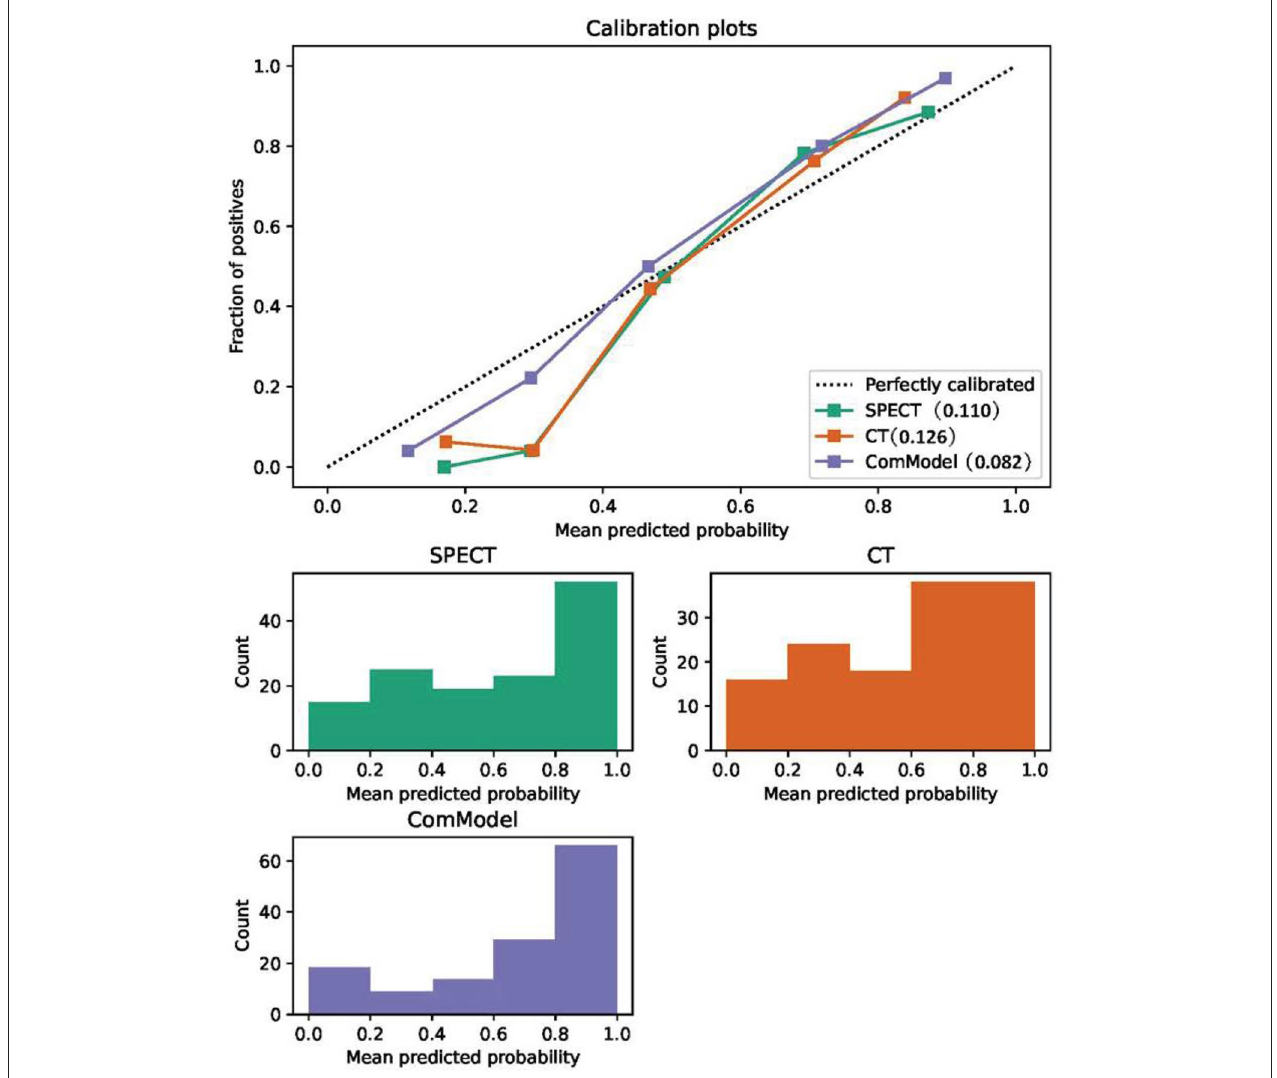
FIGURE 4 | Comparison of the calibration curve and Brier score of different models. All three model’s calibration curves were closed to ideal curves, indicating that the models had good fitness and predictive ability. The following figure shows the distribution of the probability of diagnosis for different